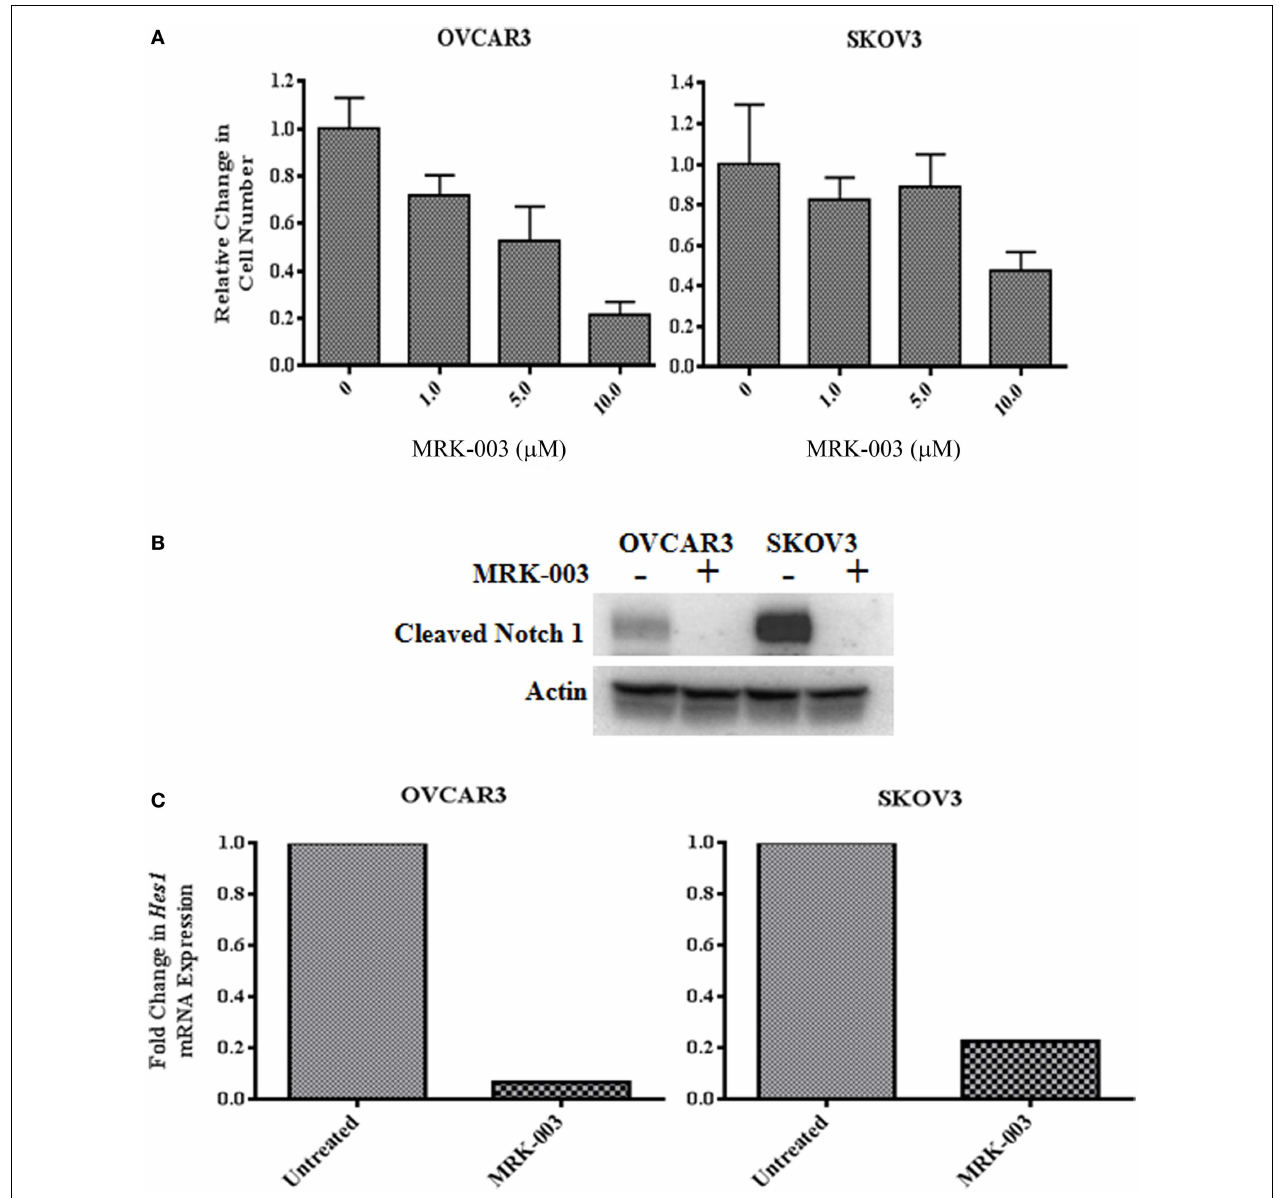
with 5 µ M (OVCAR3) or 10 µ M (SKOV3) MRK-003 for 6h reveals a marked decrease in expression of cleaved Notch1 (Val1744). An anti-Pan-Actin antibody was used to confirm equivalent loading of samples. Control = cells incubated with medium only. (C) qPCR analysis of Hes1 gene expression in MRK-003 treated OVCAR3 and SKOV3 cells, harvested 6h post treatment, showed significantly decreased Hes1 transcript levels housekeeping gene β - actin